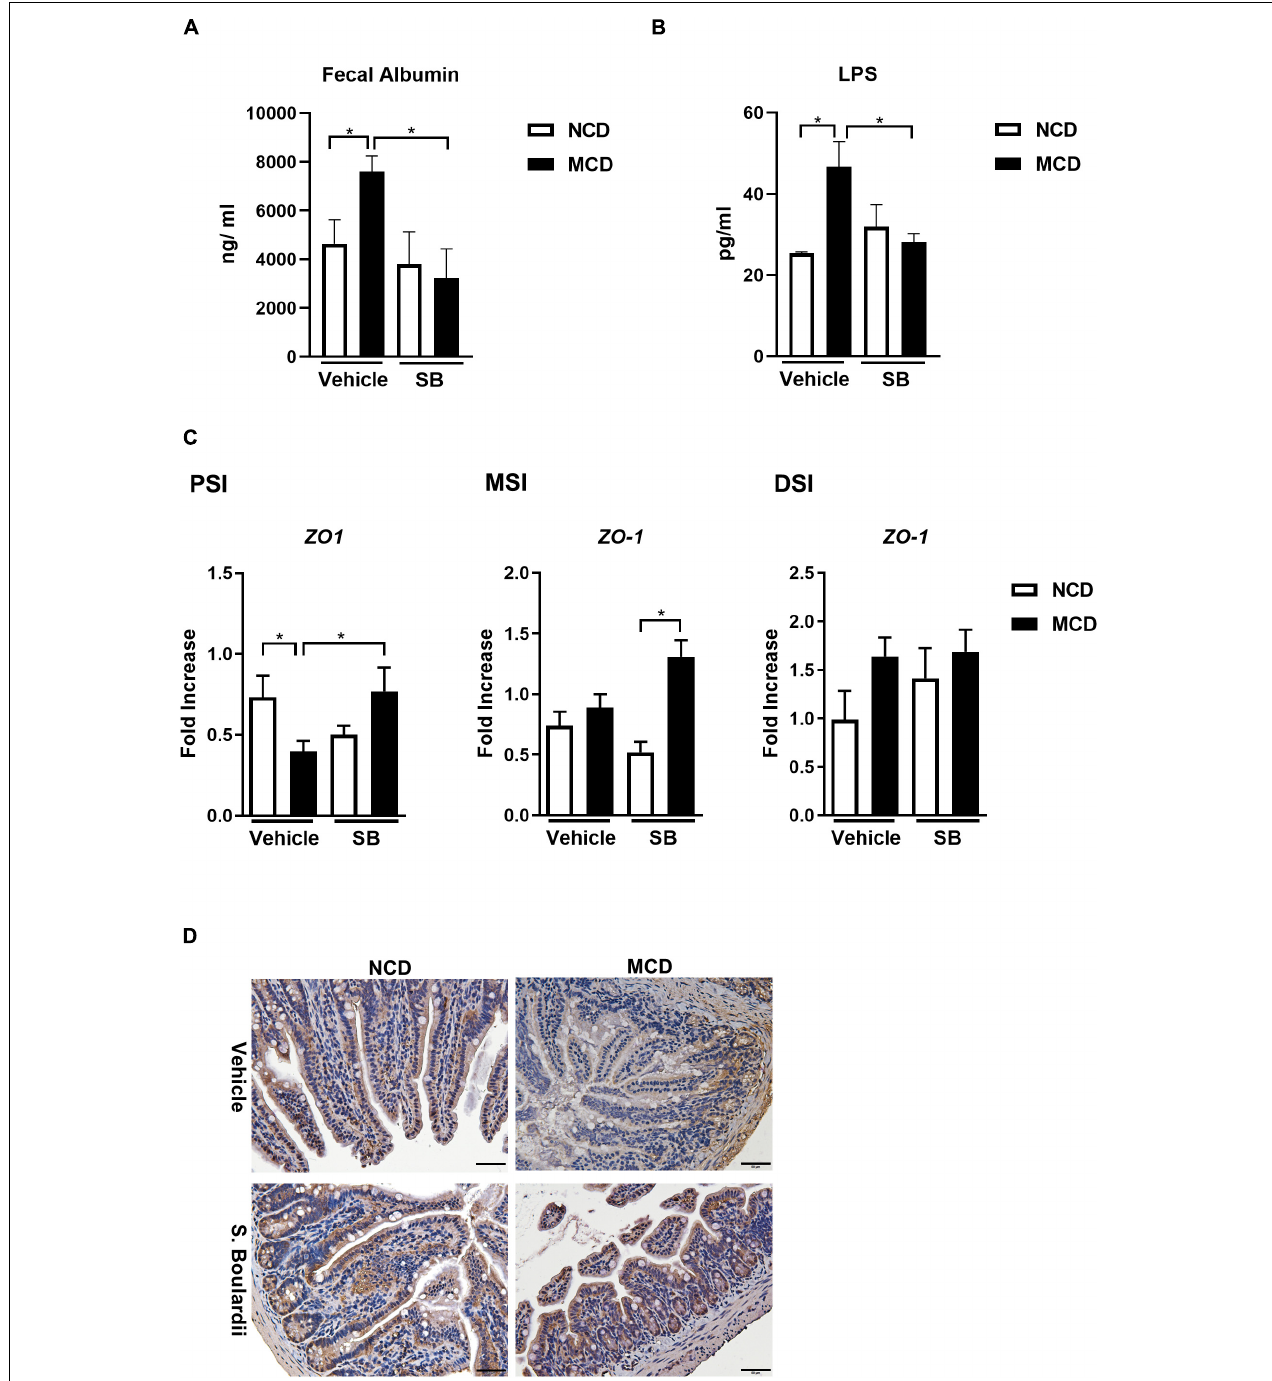
FIGURE 6 | SB decreased the MCD diet-caused leaky gut with less Lipopolysaccharide translocation. (A) Fecal albumin measured by ELISA. (B) Plasma Lipopolysaccharide (LPS) level. (C) Intestinal expression of intestinal barrier gene, ZO-1 , in the proximal, middle and distal small intestine. (D) Representative liver sections of ZO-1 immunohistochemical staining of the distal small intestine. Scale bars: 50 µ m. * p < 0.05.